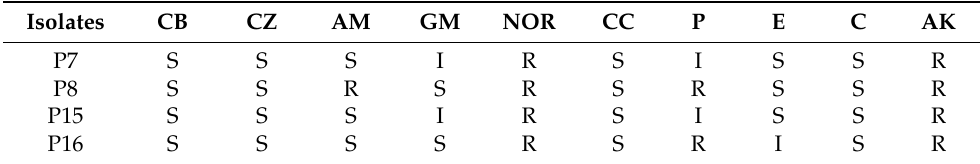
Table 5. Antibiotic susceptibility of selected LAB strains.